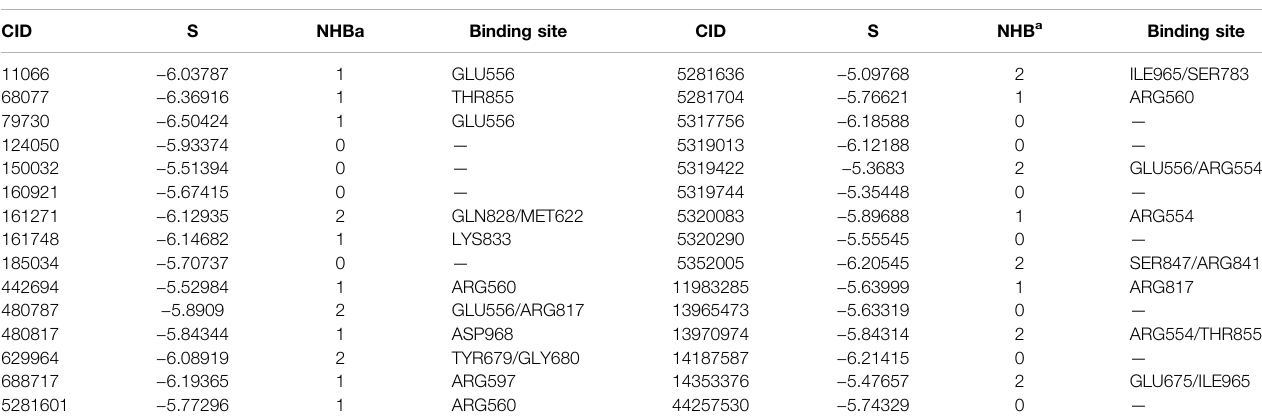
TABLE 6 | Docking results of potential inhibitors with